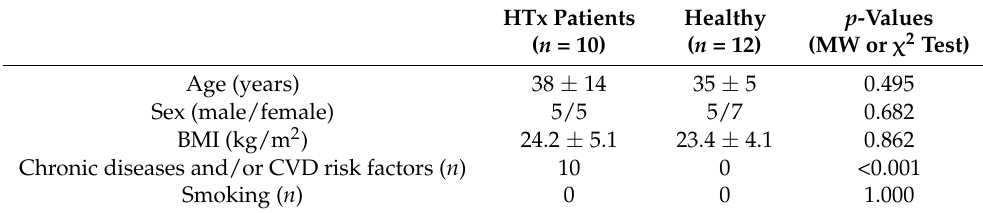
Table 1. Summary of HTx and control patient